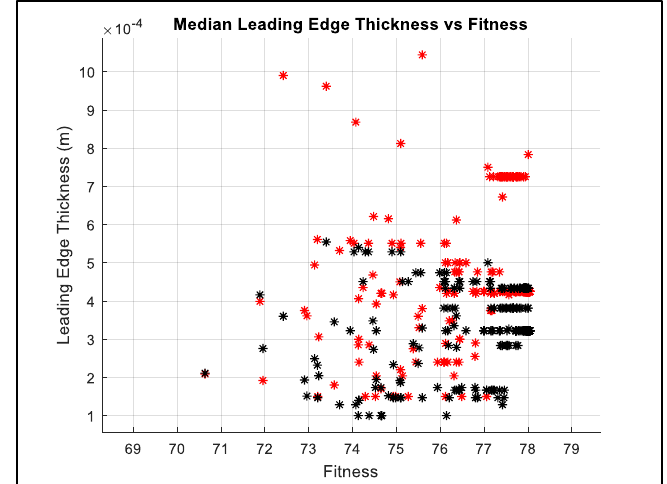
Figure 16. Leading edge thickness at the median layer vs. fitness for rotor (red) and stator (black).